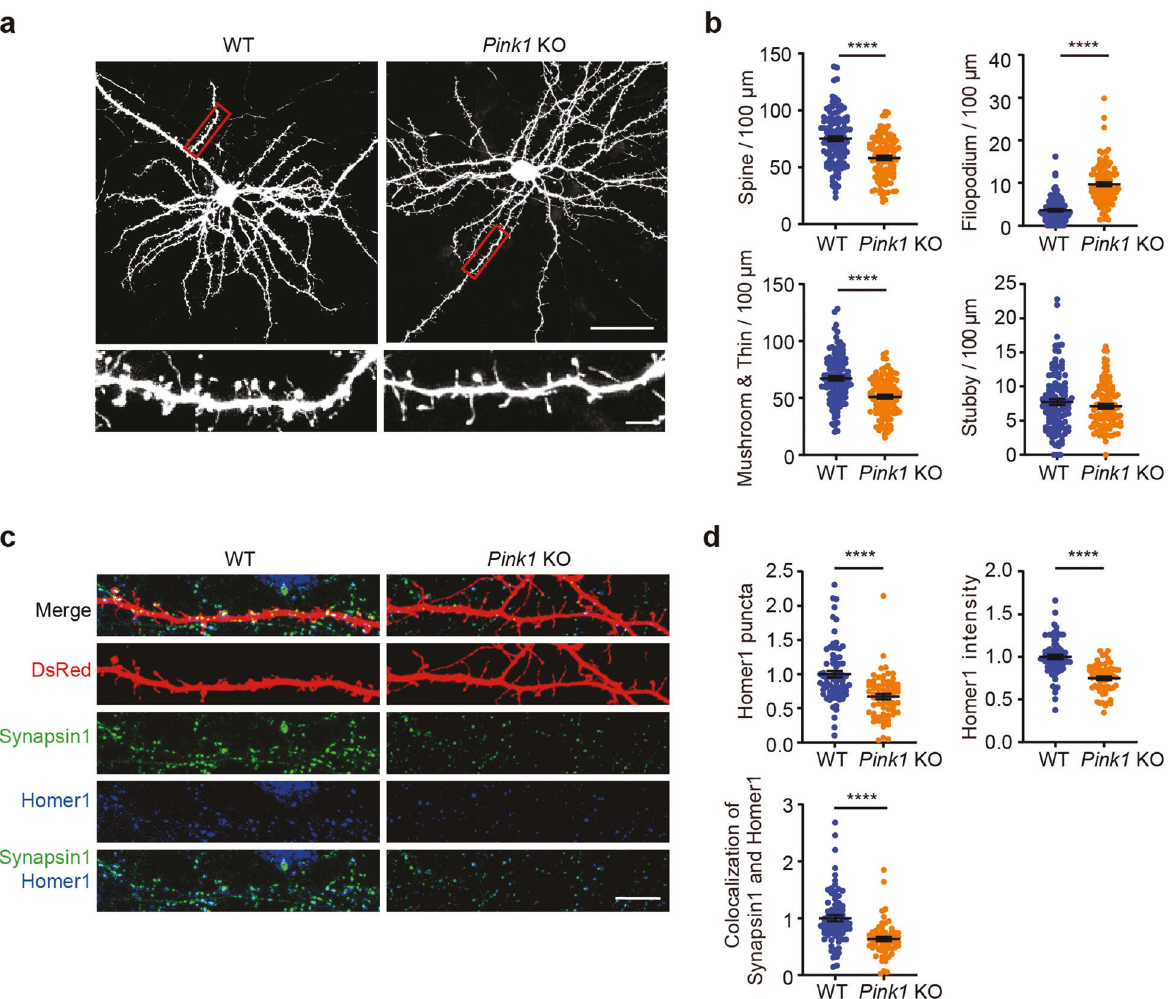
Fig. 1 PINK1 regulates dendritic spine development and enrichment of synaptic proteins. a Cortical neurons (DIV 6 – 8) derived from WT or Pink1 KO mice were transfected with plasmid encoding EGFP and imaged at DIV 18. Representative images of neurons with low magni fi cation (top, Bar = 50 μ m) and neurites with higher magni fi cation of gated areas (bottom, Bar = 5 μ m) were shown. b Quanti fi cation of the density of dendritic protrusions and proportion of different types of protrusions for experiments presented in a . n = 116 and 109 dendrites for WT and Pink1 KO from three independent experiments, respectively. c Cortical neurons (DIV 6 – 8) derived from WT or Pink1 KO mice were transfected with DsRed plasmid followed by staining at DIV 18. Representative images of neurons were stained with antibodies against Homer1 (blue) or Synapsin1 (green). Bar = 10 μ m. d Quanti fi cation of normalized synaptic puncta density or fl uorescence intensity of dendritic Homer1 and colocalization of Synapsin1 and Homer1 for experiments shown in c . n = 76 and 65 dendrites for WT and Pink1 KO from three independent experiments, respectively. All data were normalized with the mean value of WT dendrites in each repeat. **** P < 0.0001. Student ’ s t -test control neurons (Fig. 2k, l, Supplementary Fig. S3c, d). Paired-pulse KO mice than that of WT littermates at age of 8 weeks (Fig. 2c, d). facilitation (PPF) analysis of somatosensory cortex layer 2/3 TEM analysis on a hippocampal or cortical slice of 8-week-old mice neurons showed increased PPF in Pink1 KO mice compared to showed smaller postsynaptic density (PSD) in Pink1 KO neurons that in WT mice, indicating a lower probability of releasing than that of WT neurons (Fig. 2e, f). Notably, the presynaptic synaptic vesicles (Supplementary Fig. S3e, f). Results establish a bouton in Pink1 KO neurons was smaller and contained less physiological role of PINK1 in excitatory neuronal connectivity in synaptic vesicles compared to that in WT neurons (Fig. 2g, h, hippocampal and cortical circuits. bouton size: 0.3625 ± 0.018 µm 2 in WT neurons, 0.3038 ± 0.014 µm 2 in Pink1 KO neurons; number of synaptic vesicles per PINK1 is required for LTP induction and maintenance bouton: 52.74 ± 2.323 in WT neurons; 41.52 ± 1.731 in Pink1 KO Next, we examined whether PINK1 regulates LTP induced by theta- neurons). Results suggest defective presynaptic assembly in Pink1 burst stimulation (TBS) of the Schaffer collateral pathway in acute KO neurons. Consistently, immunoblot analysis of crude synapto- hippocampal slices. The fi eld excitatory postsynaptic potentials some (P2 fraction) extracted from cortical tissues showed that (fEPSPs) recorded in Pink1 KO Schaffer collateral-CA1 synapses was PSD95 was reduced in Pink1 KO mice (Fig. 2i, j, Supplementary Fig. greatly reduced at both initial (0 – 10 min after TBS, Pink1 KO 130.2% S2c, d) compared to that of their WT littermates. Synaptic of baseline, WT 147.4% of baseline) and maintenance phase transmission analysis showed that frequency and amplitude of (40 – 60 min after TBS, Pink1 KO 117.1% of baseline, WT 140.9% of miniature excitatory postsynaptic currents (mEPSCs) of somato- baseline) post-TBS induction (Fig. 3). Therefore, PINK1 is required sensory cortex Layer 2/3 and hippocampal CA1 neurons were for not only induction but also maintenance of LTP. signi fi cantly reduced in Pink1 KO neurons than those of WT Signal Transduction and Targeted Therapy (2022)